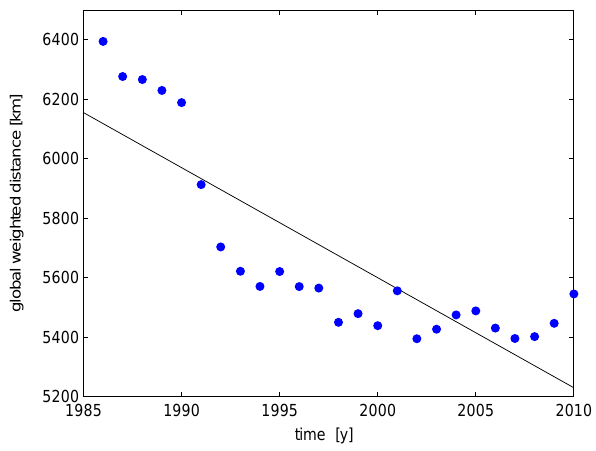
Fig. 6. Variation in time of the mean distance travelled by a generic unit of virtual water exchanged worldwide.